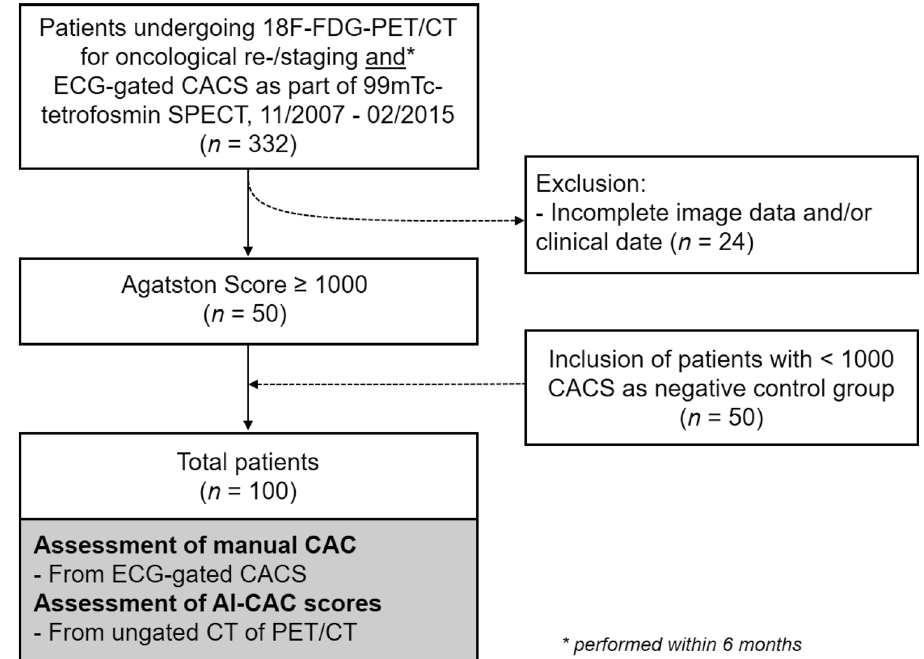
Figure 1. Flow chart of study. This figure describes exclusion and inclusion criteria for patients included in the